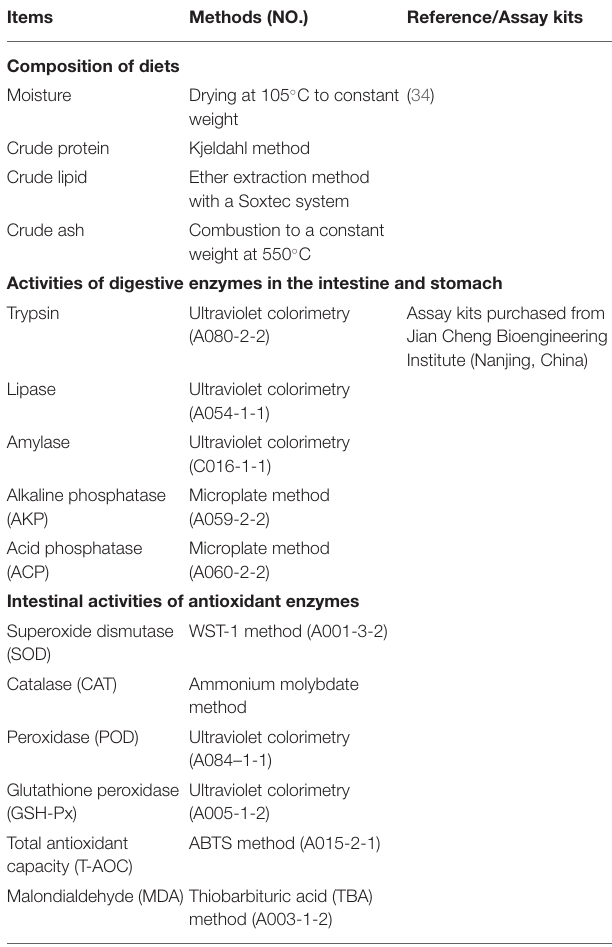
TABLE 3 | The chemical analysis used in the experiment. Items Methods